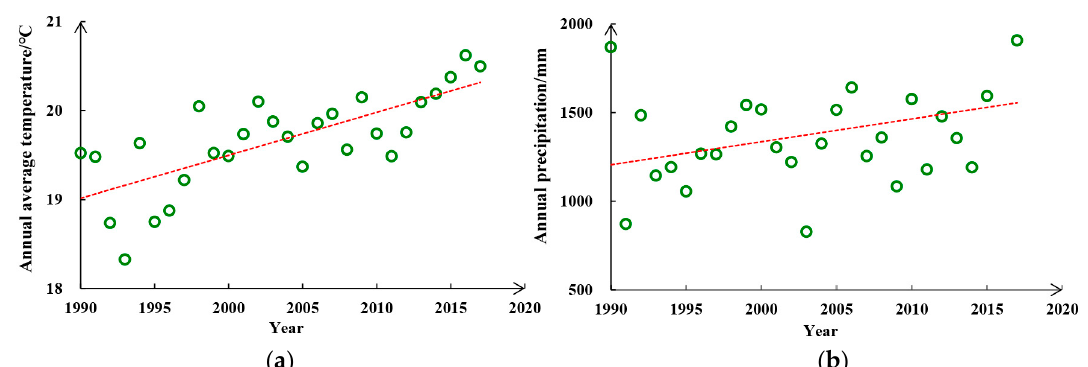
Figure 10. Change in annual average temperature and annual precipitation in the Quanzhou Bay Estuary Wetland Nature Reserve (QBEWNR) from 1990 to 2017. (a) Annual average temperature in QBEWNR from 1990 to 2017; (b) annual precipitation in QBEWNR from 1990 to 2017.